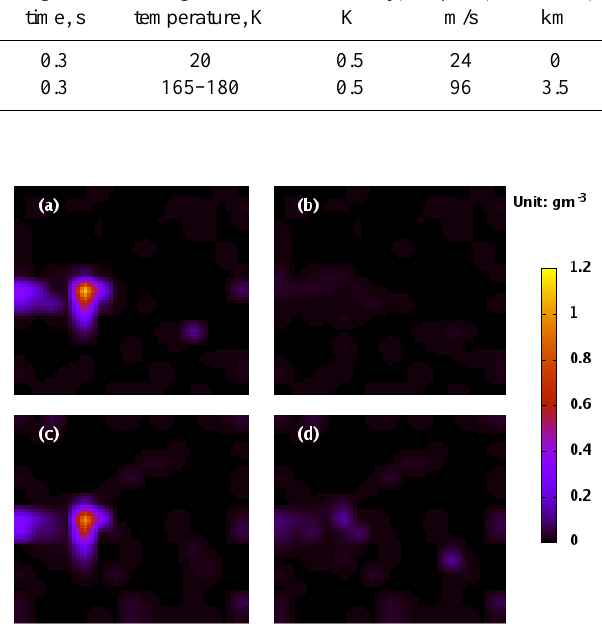
Figure 6. The puffy cumulus clouds retrieved using the ground-based and airborne setups, Fig. 6. The puffy cumulus clouds retrieved using the ground-based as well as the corresponding images of error. (a) Retrieved liquid water field by the ground-based setup; (b) The error of the ground-based retrieval; (c) Retrieved liquid and airborne setups, as well as the corresponding images of water field by the airborne setup; (d) The error of the airborne retrieval.